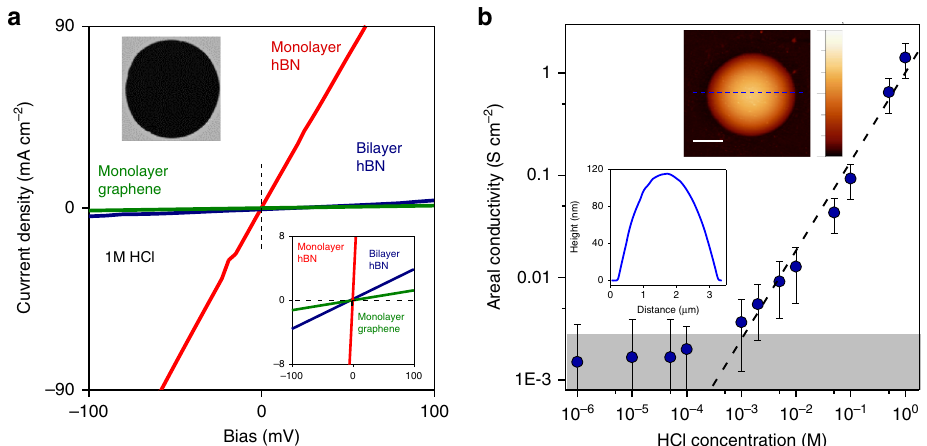
Fig. 1 Proton transport through 2D crystals studied using aqueous solutions. a Examples of I – V characteristics for 1 M HCl. Bottom inset: zoom-in. Top inset: electron micrograph of a suspended hBN membrane (aperture diameter, 2 µ m). b Concentration dependence of the areal conductivity σ for monolayer hBN. Gray area indicates our detection limit given by parasitic leakage currents. Error bars: SD from different measurements. Dashed line: best linear fi t to the data. Top inset: atomic force microscopy (AFM) height pro fi le of an ‘ in fl ated nanoballoon ’ . Here, graphene monolayer seals a micrometer- sized cavity containing pressurized Ar. The pressure difference across the membrane makes it to bulge up. Lateral scale bar, 1 μ m; color scale, 130 nm. Bottom inset: AFM line trace taken along the blue dotted line in the top inset